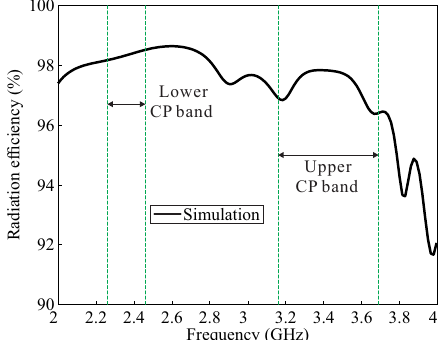
Figure 6. Simulated radiation efficiency of the proposed